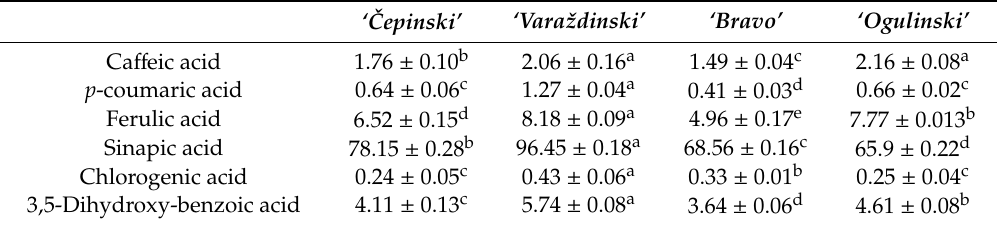
Table 3. Phenolic acid content (mg / kg) of cabbage cultivars ( ‘ ˇCepinski’ , Varaždinski’ , ‘Bravo’ , ‘Ogulinski’